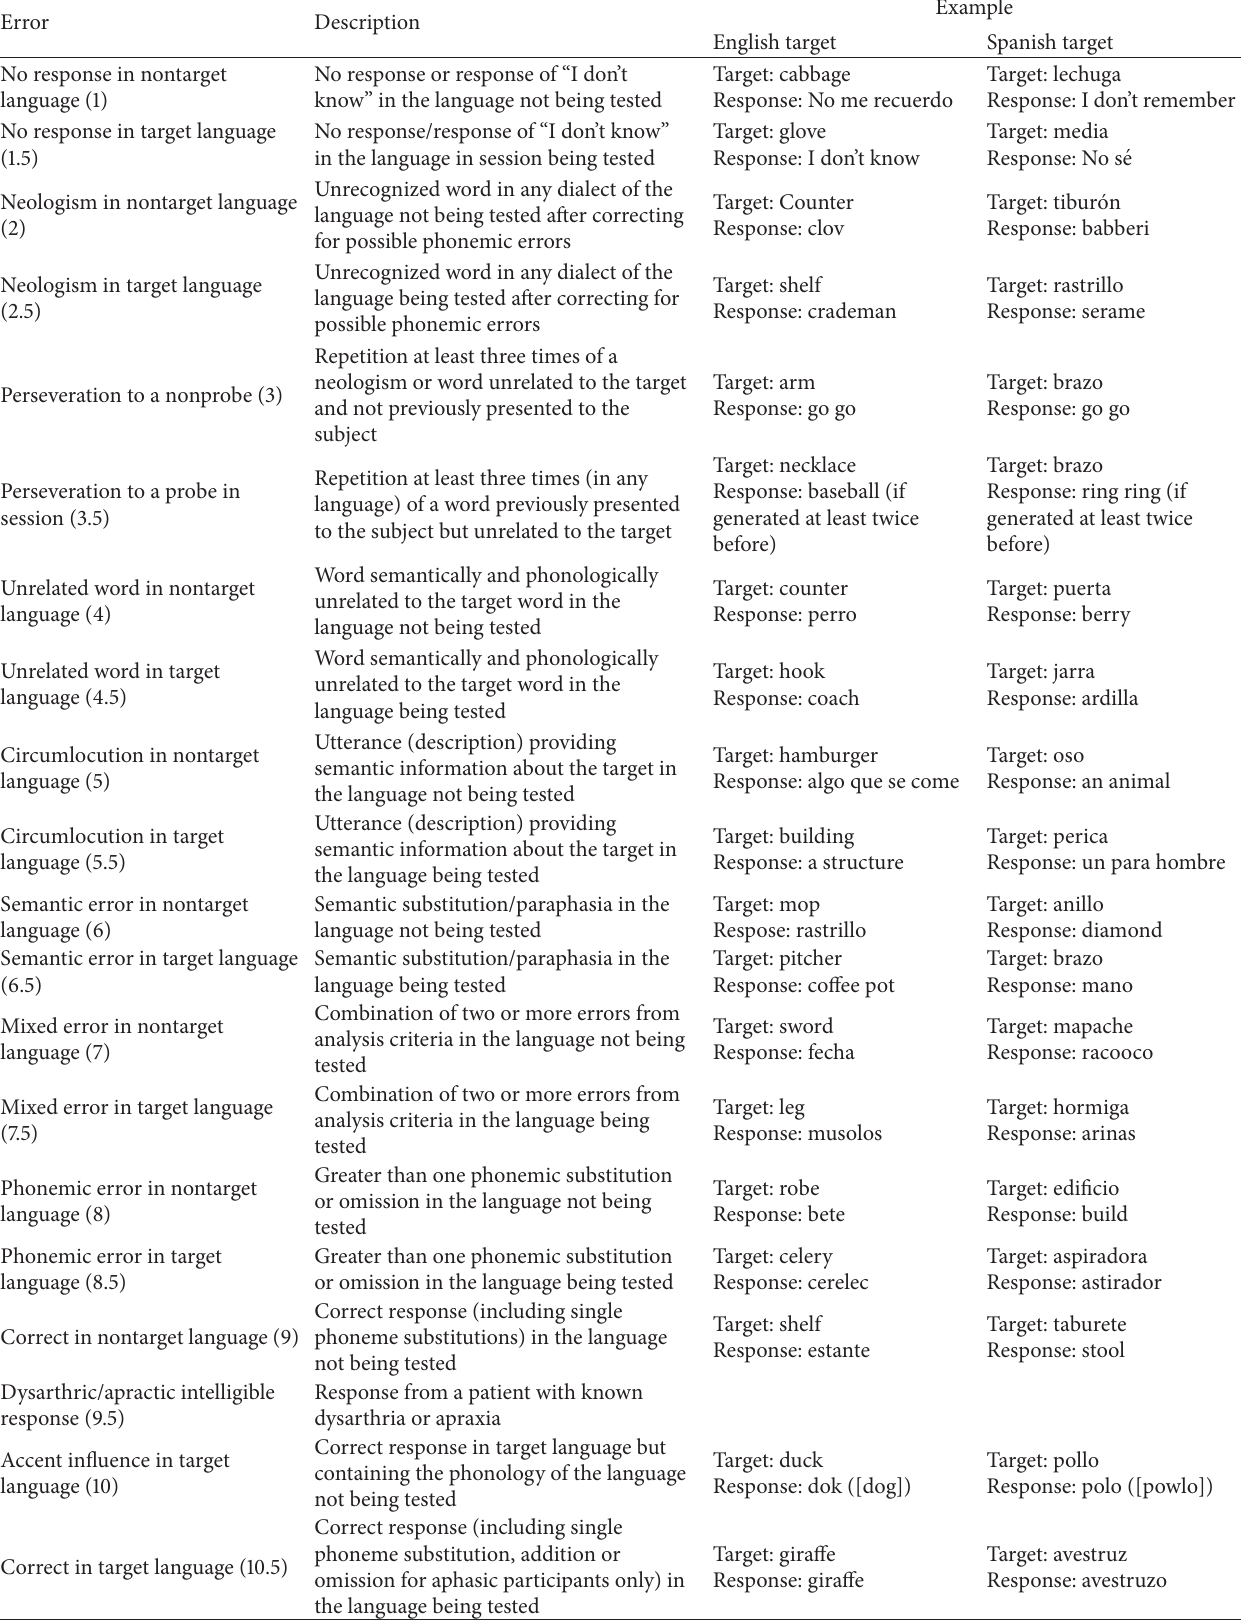
Table 6: Description of error types and examples of errors produced in English and